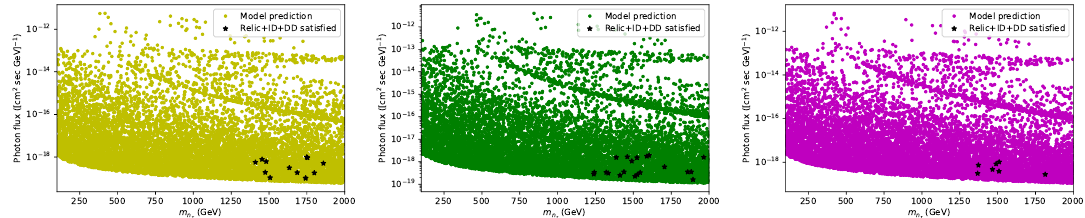
Figure 4 . Indirect detection restrictions for scotino dark matter. The photon flux versus dark matter mass with Case (i) — degenerate scotino mass scenario (Left), Case (ii) — small mass splitting (Middle), and Case (iii) — large mass splitting (Right). All points satisfy constraints from Fermi-LAT [34], while the black asterisks are also consistent with relic density + direct detection restrictions from PICO-60 and XENON1T